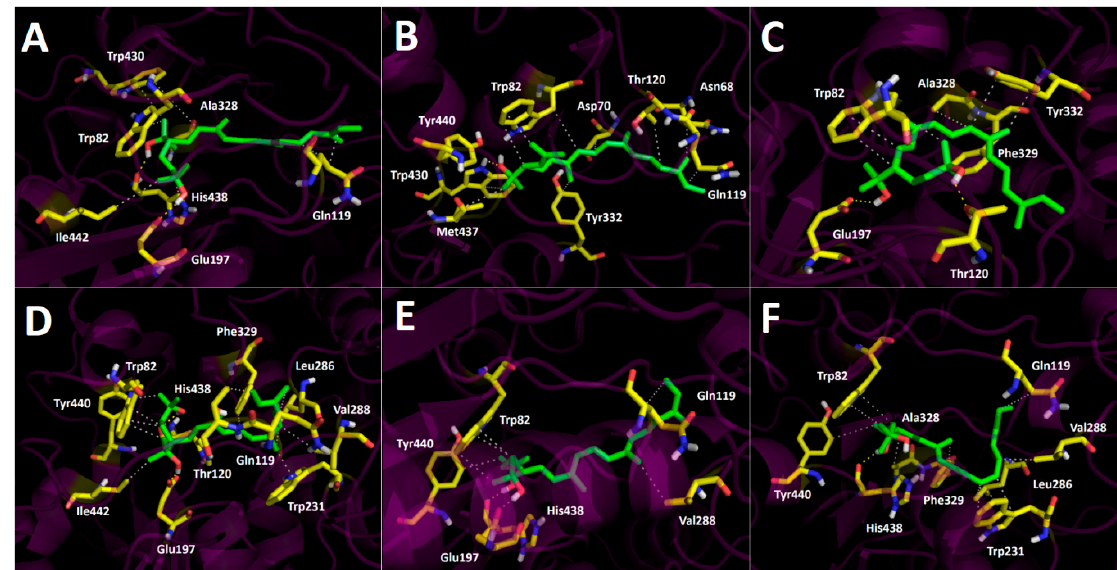
Figure 10. Predicted binding mode and predicted intermolecular interactions of different fragments (Figure 8) in the catalytic site of butyrylcholinestesase; ( A ) fragment M 1 in the catalytic site; ( B ) fragment M 2 in the catalytic site; ( C ) fragment M 3 in the catalytic site; ( D ) fragment M 4 in the catalytic site; ( E ) fragment M 5 in the catalytic site; ( F ) fragment M 6 in the catalytic site.